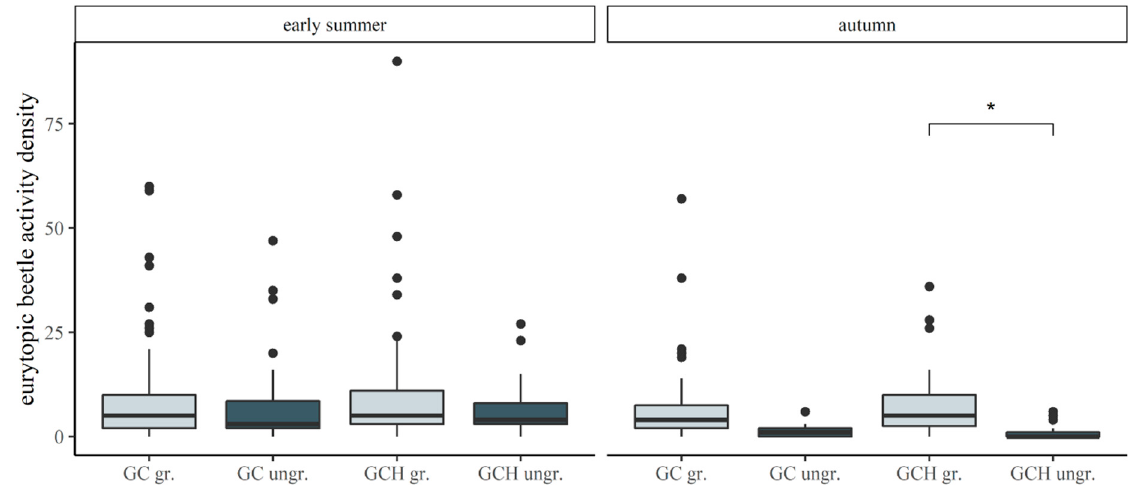
Figure 6. Eurytopic beetle activity densities of the different managements (grazed and ungrazed) and mixtures (grass–clover GC and grass–clover herbs GCH) in early summer and autumn. p -values are indicated as * p < 0.05.